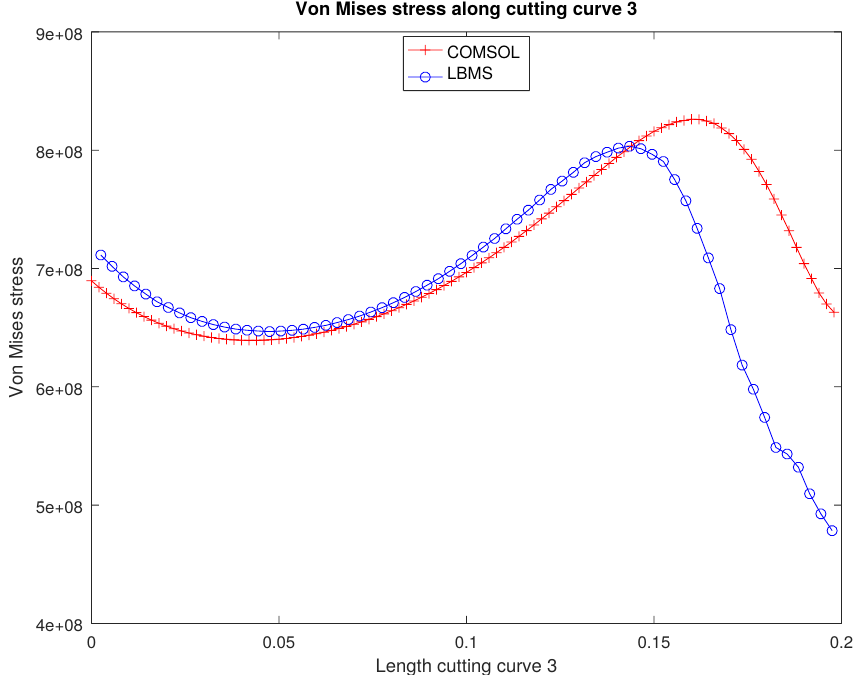
Figure A20. Von Mises stress along cutting curve C 3 for case E = 200 GPa, ν = 0.15 with triangular